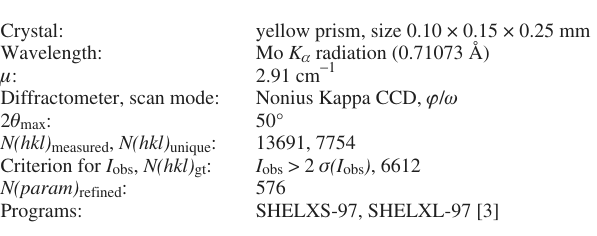
Table 1. Data collection and handling.